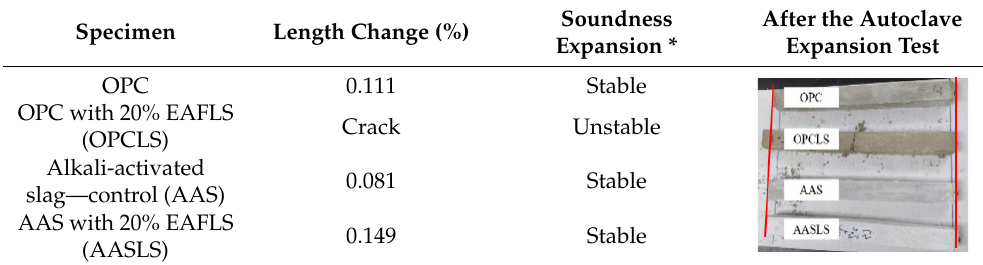
Table 3. Effect of different hydration processes with EAFLS on volume stability.